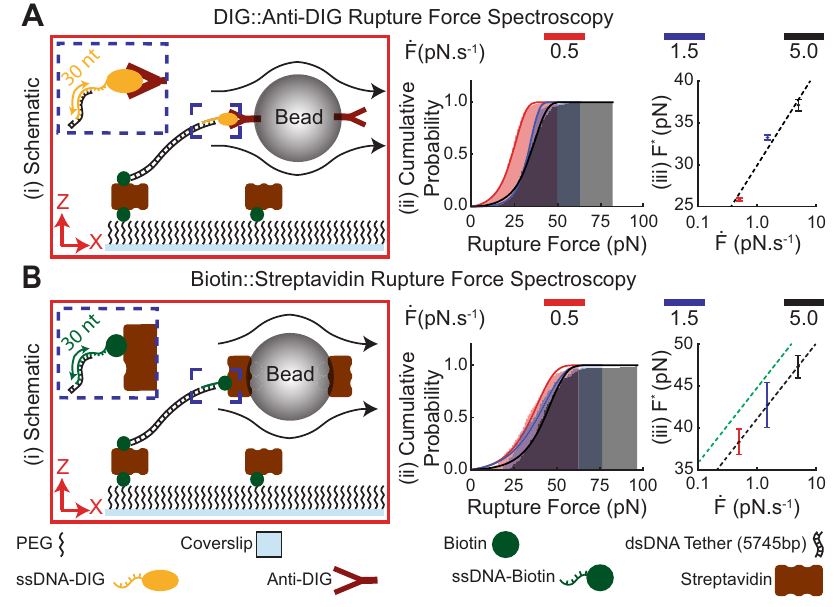
Fig. 2 | Hydrodynamic force spectroscopy of the Biotin-Streptavidin and digoxigenin (DIG)-AntiDIG binding interaction. A (i) Schematic of the setup used to examine the dissociation force of DIG and Anti-DIG binding interaction. The tether included a DIG end that enables binding to beads functionalized with Anti-DIG and a biotin end that enables binding of the tether to the streptavidin on the coverslip surface. (ii) Cumulative probability histogram of the recorded rupture forces under three different loading rates and (iii) the most probable rupture force (F * ) with respect to applied loading rate ( _ F) for DIG-AntiDIG binding interaction. N=3 most probable rupture forces were estimated based on random selection without replication of the recorded rupture force data under eachloadingrate.TheestimatedF * valuesarepresentedasmeanvalues±SD. B (i) Schematic of the setup used to execute hydrodynamic force spectroscopy on biotin-streptavidin binding interaction. The tetherincludedtwo biotinendsthat enable binding ofthe tether tobeads functionalized withstreptavidin and to the